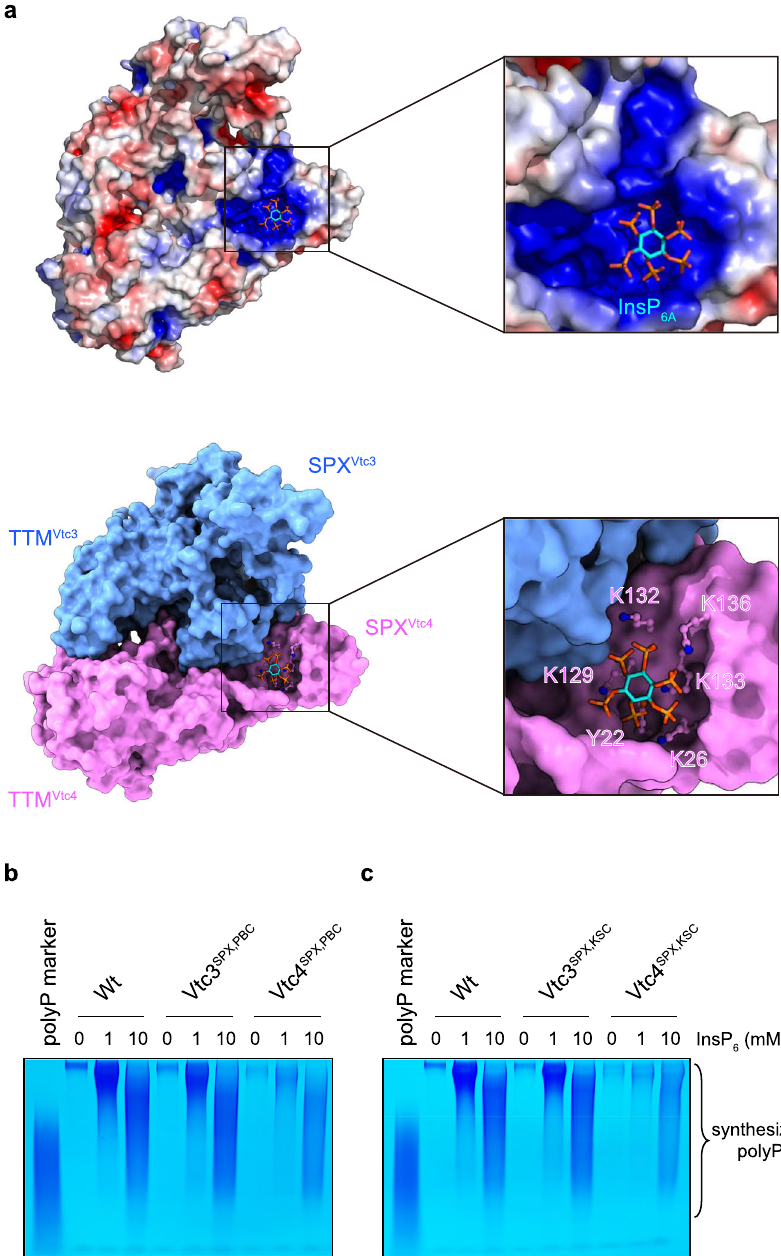
Fig. 3 | Activation of the VTC complex by SPX Vtc4 -sensed InsP 6 messenger. a Electrostatic surface ( Top ) andmolecularsurface ( Bottom ) representation ofSPX and TTM domains in InsP 6 -activated Vtc1/Vtc3/Vtc4 R264A/R266A/E426N complex, dis- played in the same perspective. Electrostatic potential is calculated with the APBS plugininPyMOL,coloredanddisplayedinascalefromred( − 5kT/e)toblue(+5kT/ e). SPX Vtc4 PBC (Y22, K26, K133) and KSC (K129, K132, K136) residues are shown in stick representation. b , c Assay of VTC-catalyzed polyP synthesis. 5 μ M protein